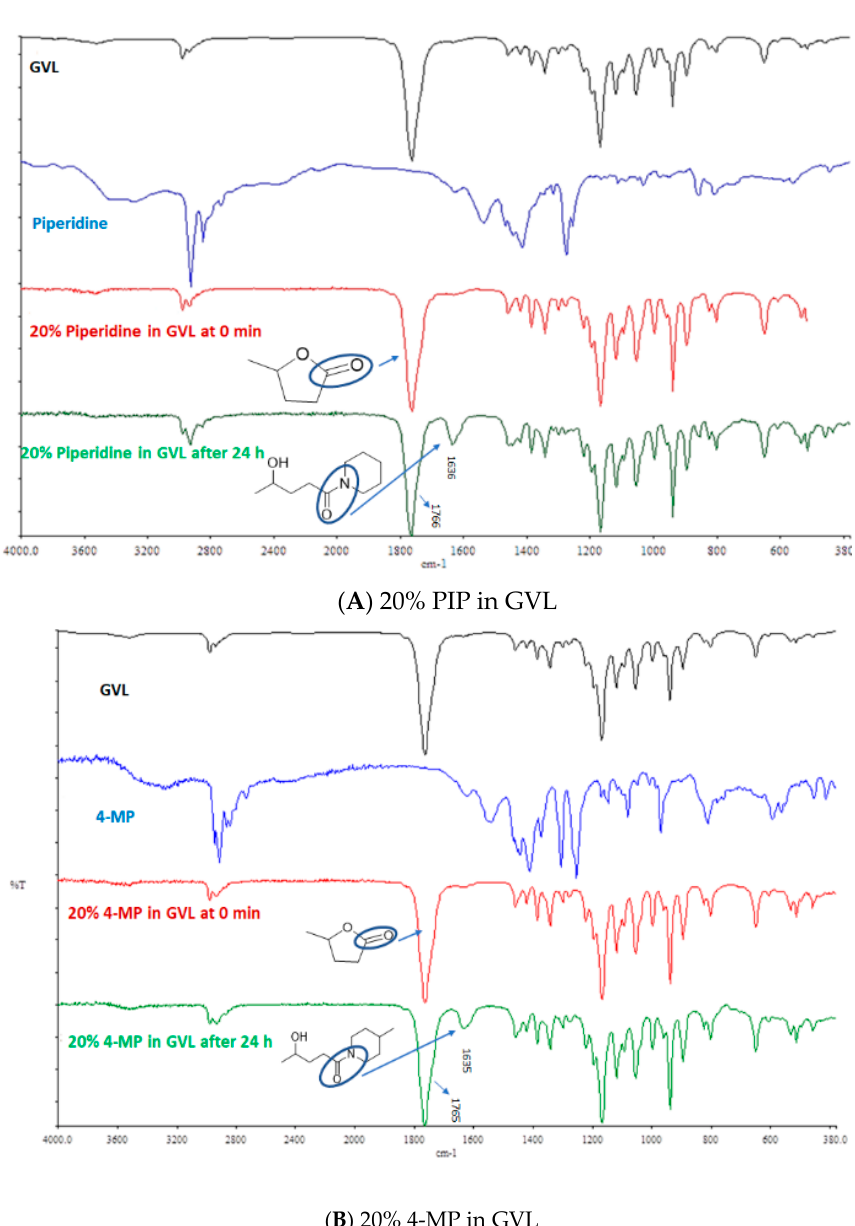
Figure 4. FT-IR comparison of base with GVL: ( A ) 20% PIP in GVL and ( B ) 20% 4-MP in GVL.